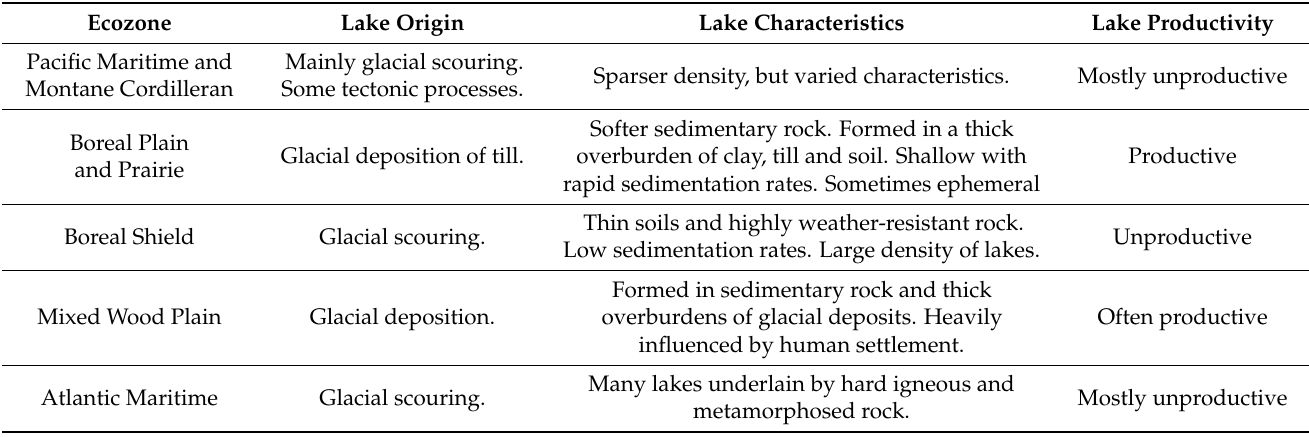
Productive Unproductive Often productive Mostly